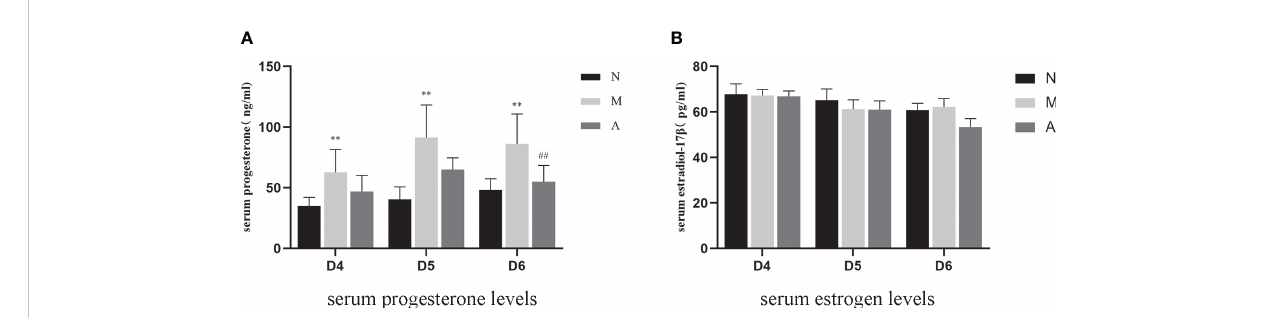
FIGURE 9 The expression of serum progesterone (A) and estrogen (B) levels (n=7). *or** represents that there is signi fi cant difference between M and N groups ( P < 0.05 or P < 0.01), #or ## represents that there is signi fi cant difference between A and M groups ( P < 0.05 or P < 0.01). D, The embryo day; N, Normal group; M, Model group; A, Acupuncture group.